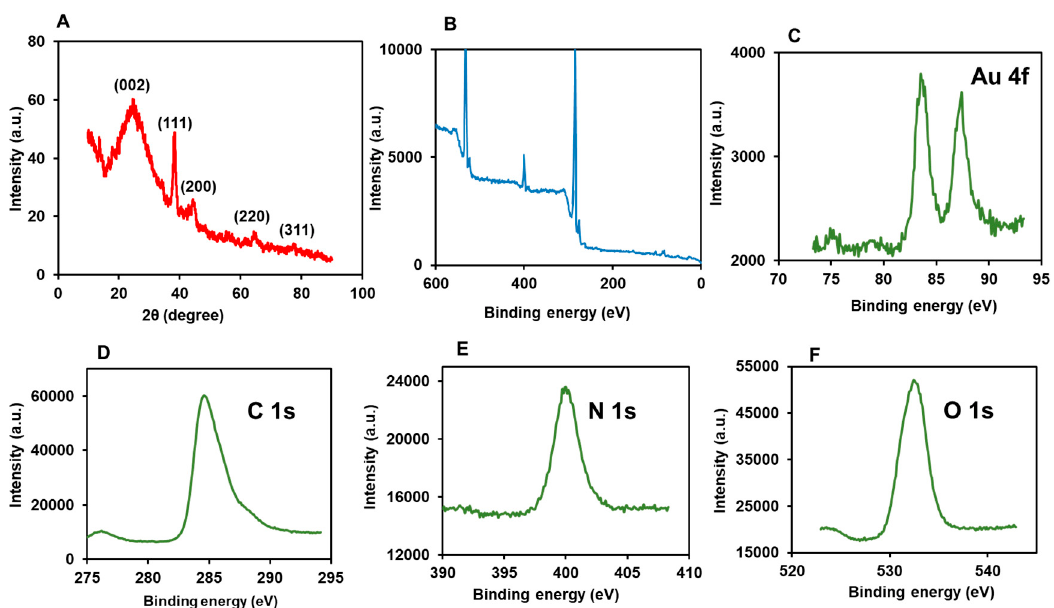
Figure 3. ( A ) SEM images of rGO, ( B ) rGO/PDA, and ( C ) rGO/PDA/AuNPs. ( D , E ) TEM images of rGO/PDA/AuNPs at different magnifications. ( F ) EDX spectrum of rGO/PDA/AuNPs.